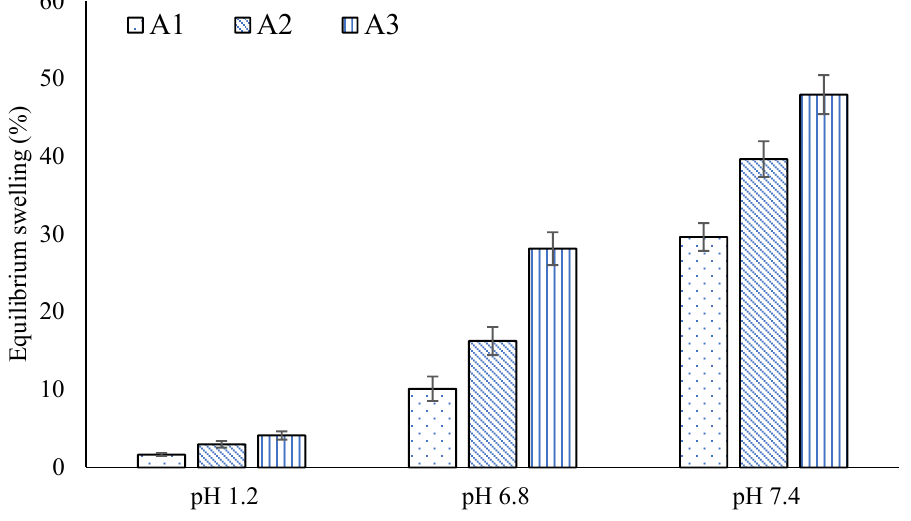
Figure 3. Effect of AM on equilibrium swelling of 5-FULH.